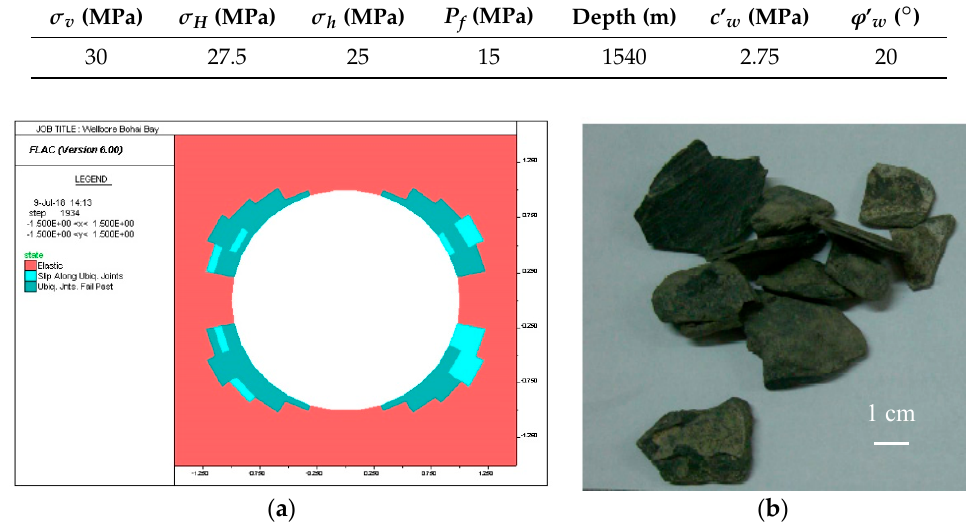
Figure 21. ( a ) Slip failures in a wellbore drilled in Bohai Bay (China), obtained with FLAC. Mud pressure = 16 MPa. ( b ) Shale cavings from a horizontal wellbore, modified from [8].